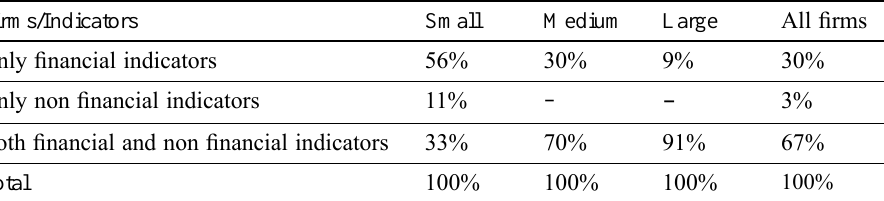
Table 12. Types of indicators used and firm